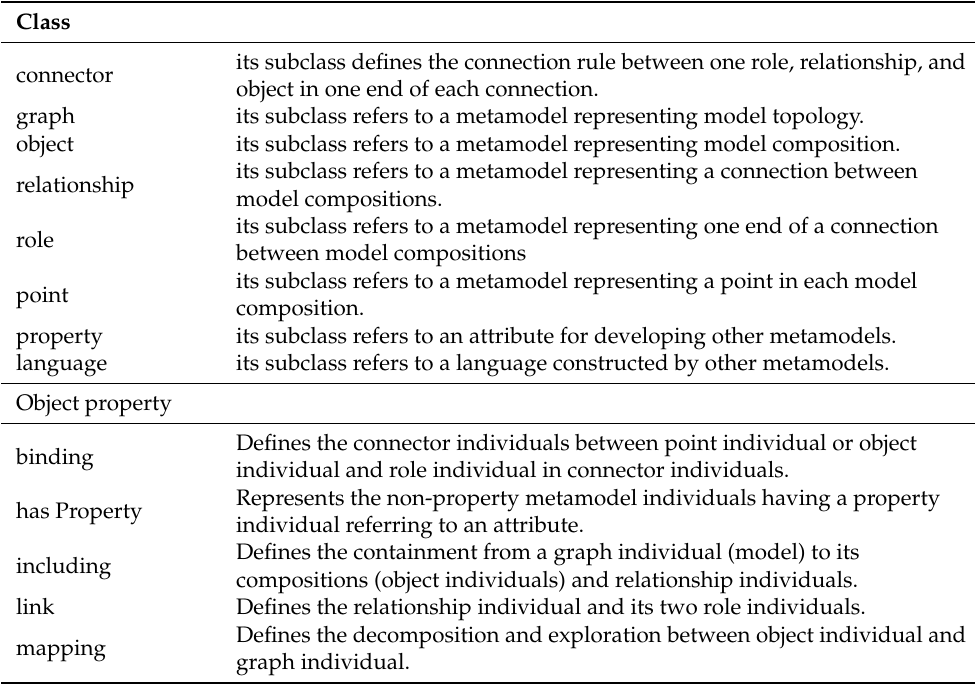
Table 1. Ontology class and object